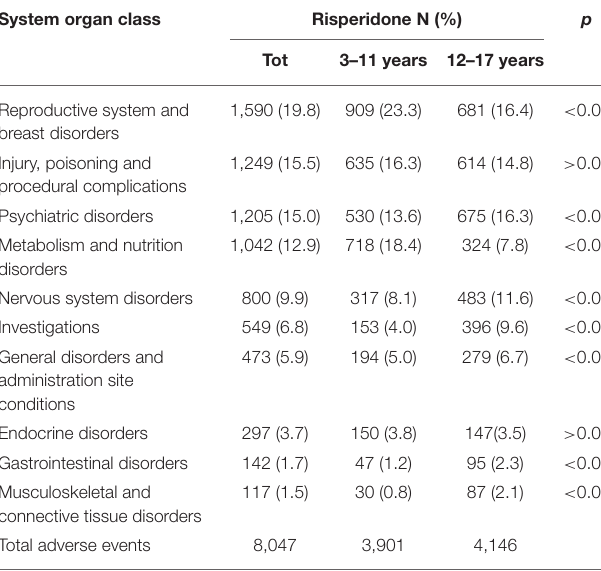
TABLE 6 | Distribution of adverse drug events (AEs) categorized according to the system organ classes (SOCs) and involving risperidone as a suspected drug, stratified for pediatric patients aged 3–11 and 12–17 years recognized in Eudravigilance spontaneous reporting system from 2016 to 2018.